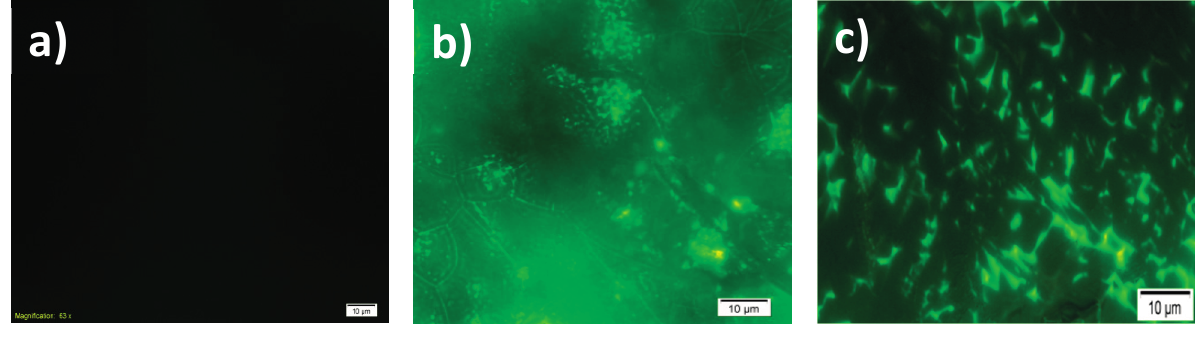
Figure 3. Fluorescence images of ITO surface ( a ) and SNS-NH 2 /SNS-NH 2 -Fc before ( b ) and after ( c ) GOx immobilization; 100× magnification (scale bars = 10